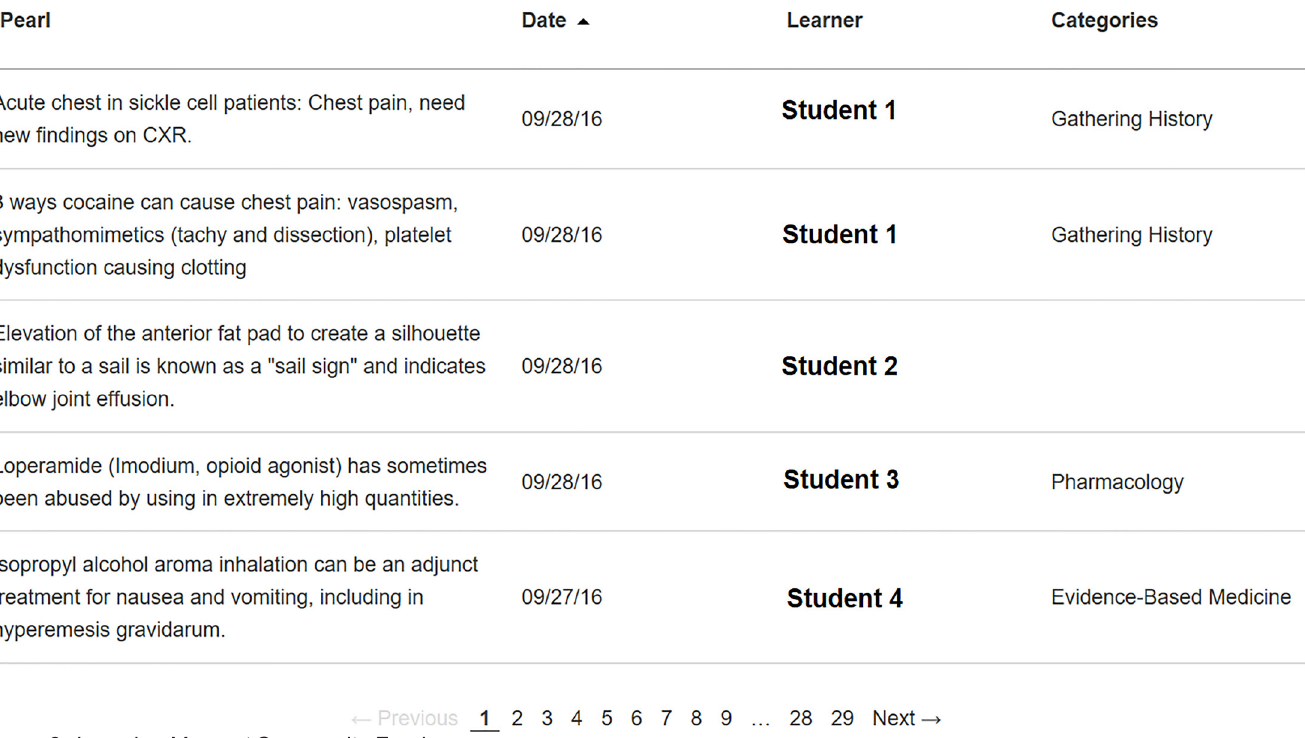
Figure 3. Learning Moment Community Feed.